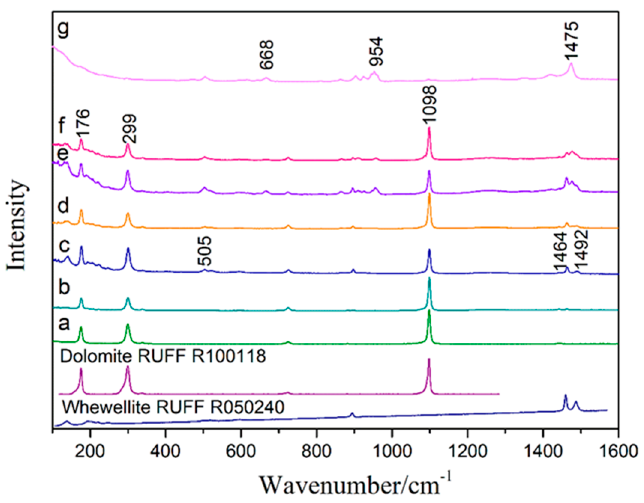
Figure 3. Raman spectra of untreated and treated samples: (a) UT, (b) AO, (c) 0.02 mol/L CA, (d) 0.04 mol/L CA, (e) 0.06 mol/L CA, (f) 0.08 mol/L CA, (g) 0.10 mol/L CA.